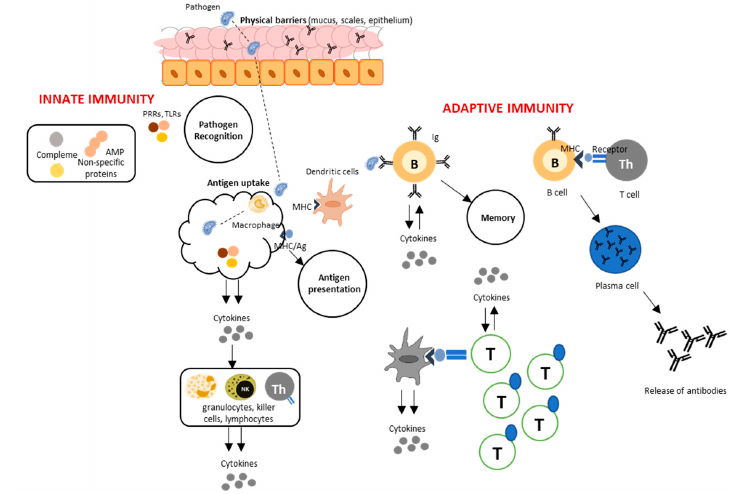
Figure 1. Immune response at the fish mucosa. When pathogens succeed to infiltrate the physical barriers, the innate immune system is triggered by the action of pathogen recognition receptors (PRRs). Antigen uptake results in the release of cytokines that activates different types of cells involved in inflammatory processes, and antigen presentation facilitated by lymphocytes containing receptors, which leads to subsequent responses as well as memory. This diagram is the simplified version